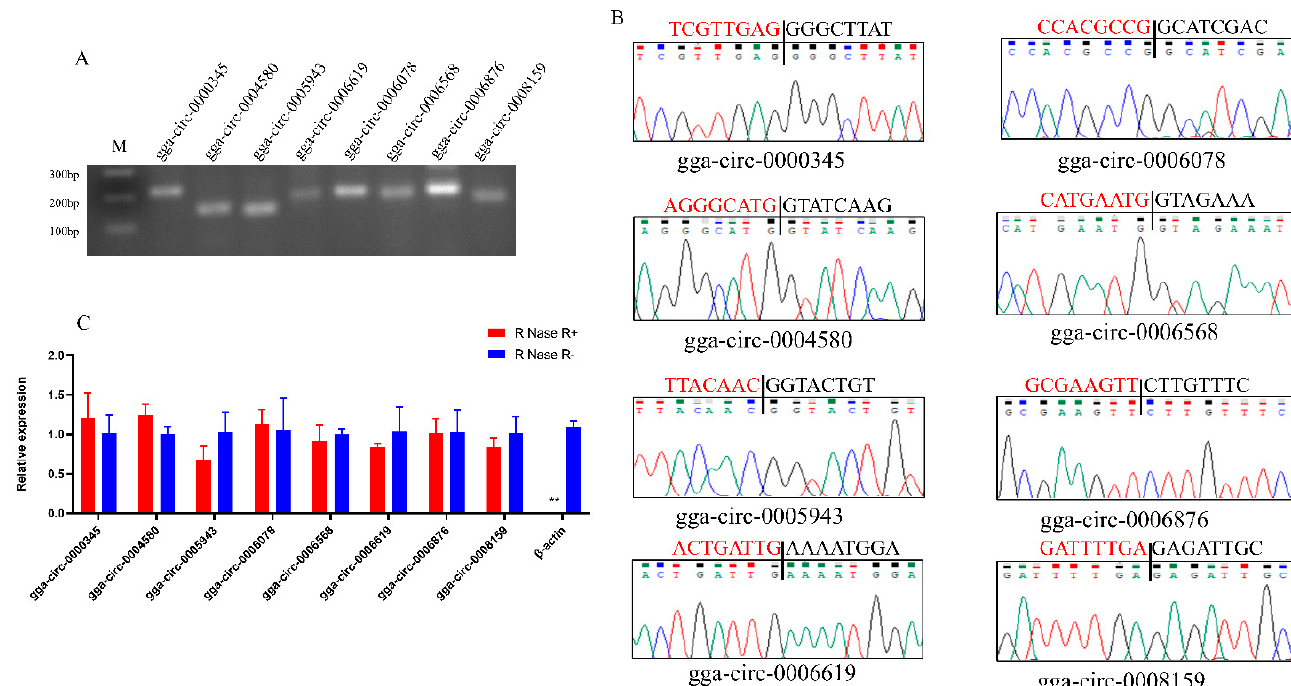
Figure 1. Validation of eight circRNAs. ( A ) Electropherogram of PCR products. M: marker. ( B ) Sanger sequencing confirmed the head-to-tail junction of eight circRNAs. Black lines indicate the location of back splicing. The region marked in red (or black) is the terminal (or start) sequence of the circRNA (junction point). ( C ) Resistance of circRNAs to RNase digestion was detected by qRT-PCR. Control was β -actin . Data are presented as mean ± SEM (n = 3).